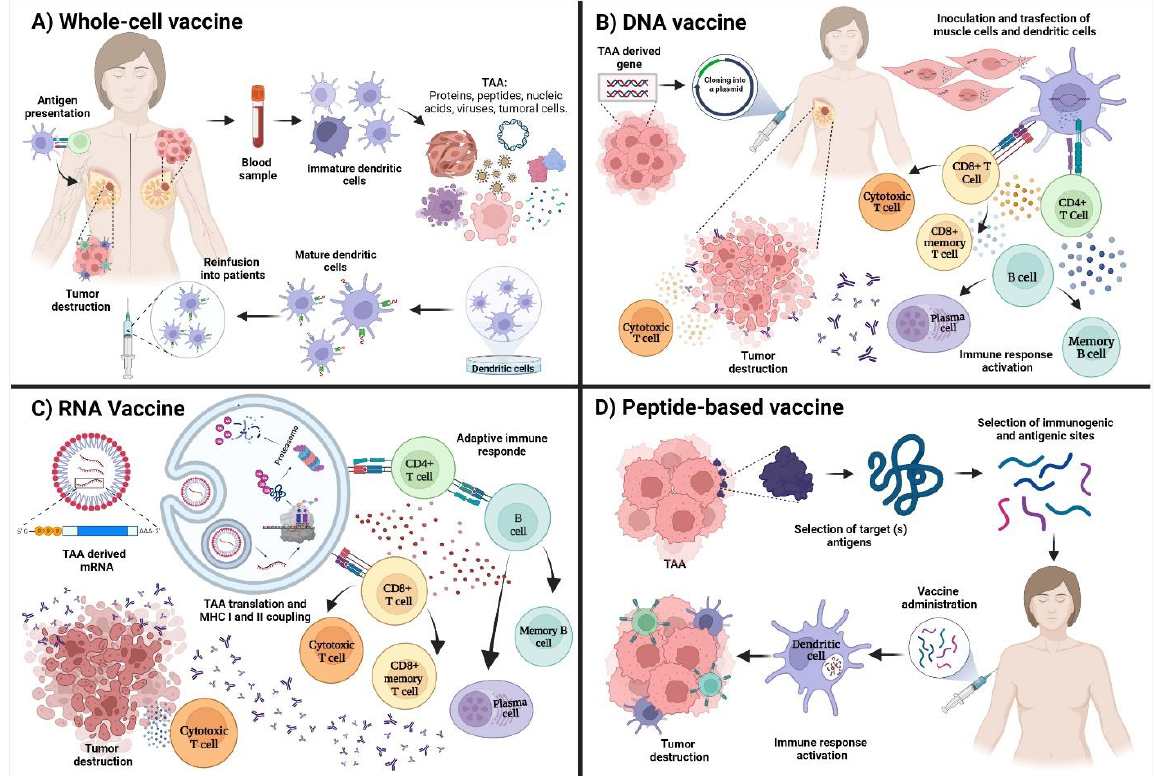
Figure 1. Types and proposed mechanisms of action in cancer vaccines. ( A ) Whole-cell vaccines are based on extracting dendritic cells from the patients. Afterward, they are pulsed with an antigenic load of proteins, peptides, nucleic acids, whole-cell lysates or cancer cells. After the maturation of dendritic cells, they are reinfused into the patient for the induction of an adaptive immune response associated with the destruction of the tumor. ( B ) DNA vaccines are based on amplifying the selected TAA and its cloning into a vector for transfection of muscle cells and dendritic cells that will pro- mote antigen presentation and the activation of T and B cells. ( C ) RNA vaccines are based on the internalization of an mRNA that encodes for a TAA. The mRNA will be translated and processed by the proteasome. The peptides will be coupled to MHC molecules to start the adaptive immune response. ( D ) Peptide-based vaccines are based on the selection of one or multiple TAA and the later selection of peptides using bioinformatic tools as IEDB (http://tools.iedb.org/main/ accessed on 30 July 2022) for the selection of peptides with immunogenic and antigenic characteristics to activate the adaptive immune response. Image created in Biorender (https://biorender.com/ accessed on 2 July 2022).